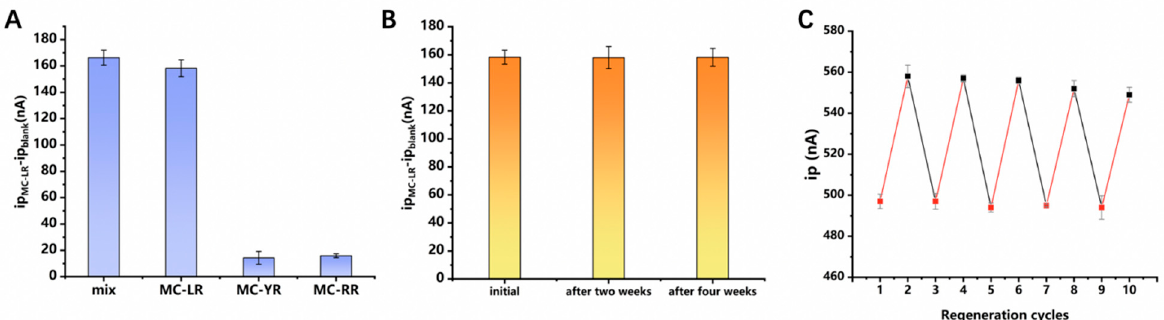
Figure 5. ( A ) Selectivity test of the aptamer sensor towards MC − LR through a comparison with the results obtained from using the mixture, MC − YR, and MC − YR, respectively; ( B ) Stability test of the aptamer sensor at initial, after two weeks, and after four weeks; the concentration of MC − LR in Figure 5A,B is 500 ng/L; ( C ) regeneration test of aptamer sensor for detection of MC − LR. The peak current, i p , was recorded in the absence/presence of 50 ng/L MC − LR after regeneration. The MC − LR − bound electrode was regenerated by rinsing with ultra − pure water for 30